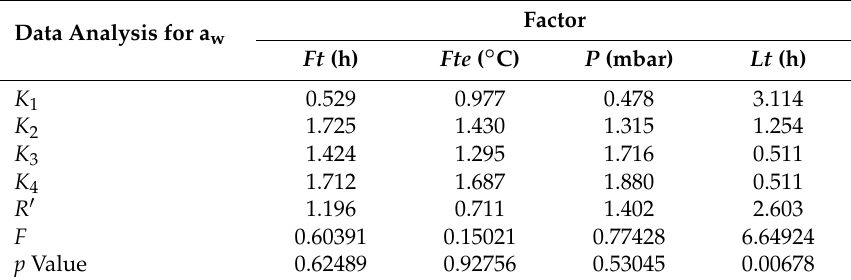
Table 5. Data analysis of dried Mexican kefir grains (MKG) water activity (a w ). Factor Data Analysis for a w Ft (h) Fte ( ◦